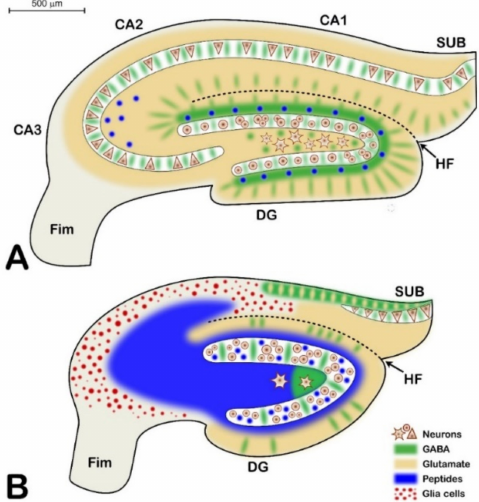
Figure 10. Scheme of the neurochemical parcellation of the hippocampus in the control ( A ) versus the PT ( B ) animals. Principal neurons are represented by triangular, circular, and multipolar shapes. GABAergic transmission is depicted in green, glutamate transmission is beige, and peptide trans- mitters are in blue. Glia is represented by red dots. The PT hippocampus is not only shrunken but also invaded by peptidergic axons, some of which do not have postsynaptic cells, and the pep- tide released is diffusing toward unknown targets. This neurochemical alteration will drastically change the function of the hippocampus, as shown by the Barnes maze experiments (CA1, CA2, and CA3 are the regions of the Ammon’s horn; DG = dentate gyrus; SUB = subiculum; Fim = fimbria; HF = hippocampal fissure; bar = 500 µ